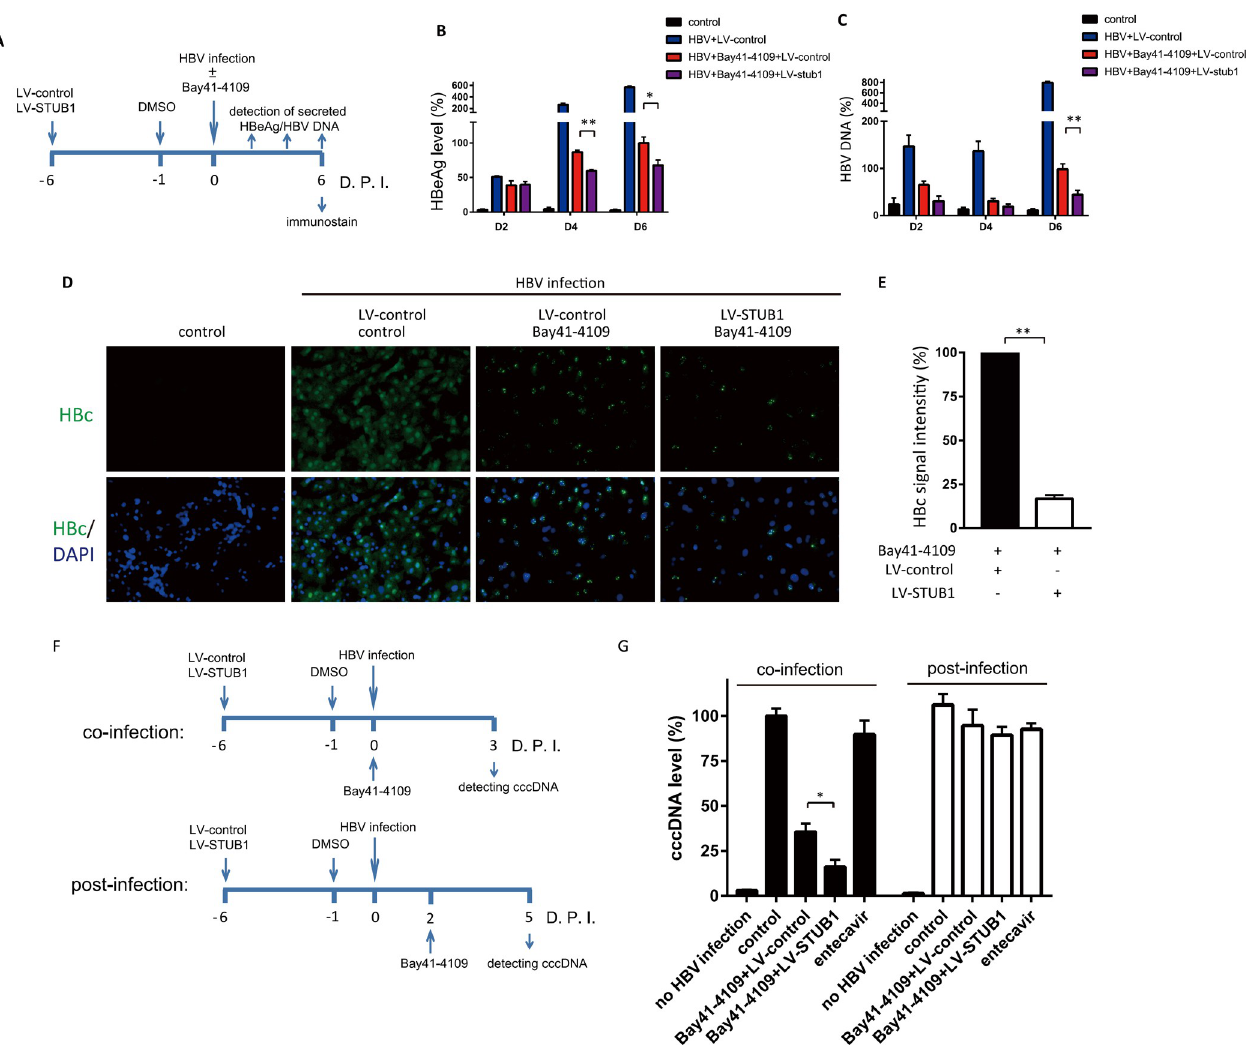
Fig 8. The effect of STUB1 overexpression in Bay41-4109-treated HBV-infected HepG2-NTCP cells. (A) Schematic diagram of the experimental procedure for HepG2-NTCP cells in Fig 8B–8D. (B, C, D) HepG2-NTCP cells transduced with LV-STUB1 or LV-control were infected with HBV at MOI of 500 genome equivalents in the presence of 2% DMSO. Bay41-4109 (1 μ M) or DMSO was added during HBV infection. The HBeAg level (B) and HBV DNA copies (C) in media were quantified at 2, 4, and 6 d after HBV infection. The error bars indicate ± SD. � p < 0.05. �� p < 0.01, p value was calculated by unpaired two-tailed student’s t-test. (D, E) Cells were immunostained for HBc (green) as indicated. Nuclei were stained with Hochest33342 (D) The fluorescence signal intensity was quantified by ImageJ (E). � p < 0.05, p value was calculated by unpaired two-tailed student’s t-test. (F) Schematic diagram of the experimental procedure of adding Bay41-4109 during (co-infection) or post HBV infection (post-infection) in LV-control- or LV-STUB1-transduced HepG2-NTCP cells. (G) Cells were treated with Bay41-4109 during (co-infection) or post HBV infection as descripted in Fig 8G. cccDNA were isolated by hirt extraction, and their levels were quantified by